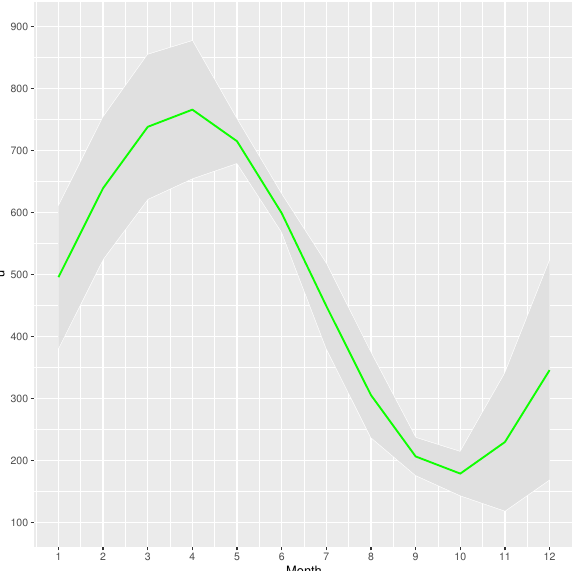
Figure 12. Parameter u varying over time for the data of Iowa river flow. The green line is the estimate of the parameter u . The shaded area is the 95% confidence interval of the estimates.